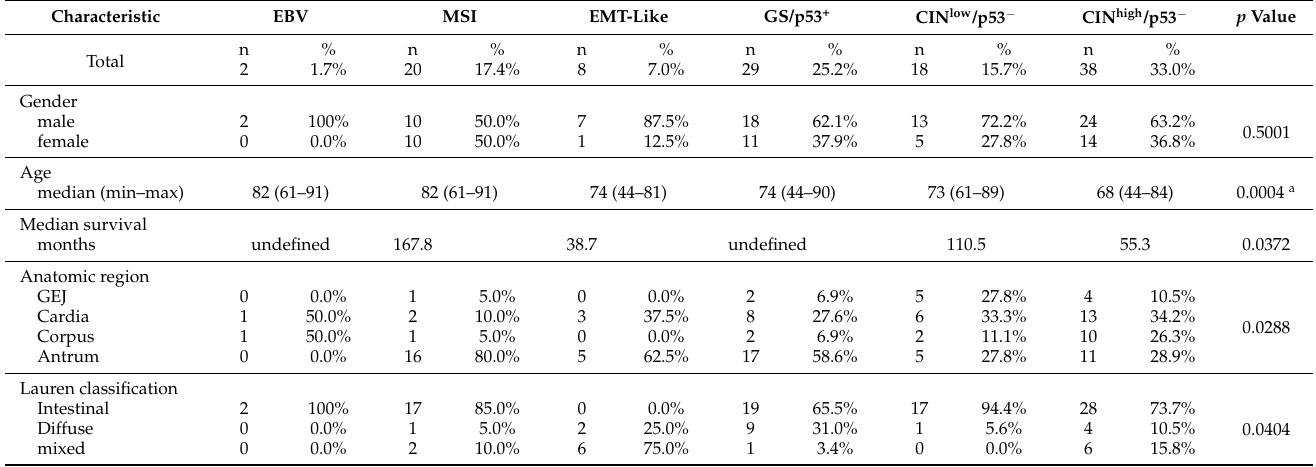
Table 2. Clinicopathological characteristics of molecular subtypes of gastric adenocarcinoma. a one-way analysis of variance (ANOVA), for all other comparisons Chi-square test was